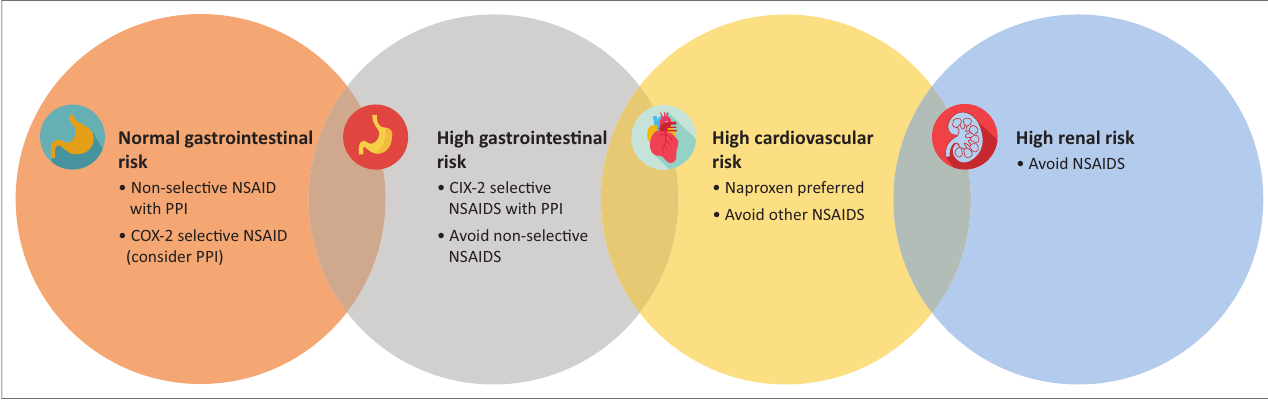
FIGURE 3: Non-steroidal anti-inflammatory drugs for knee